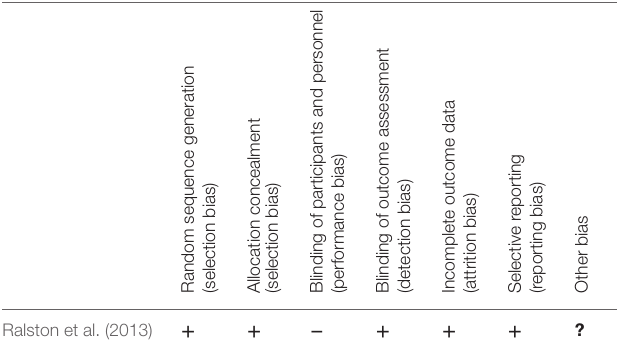
TABLE 2 | Risk of bias summary for assessing the quality of included randomized control trial (RCT) study.